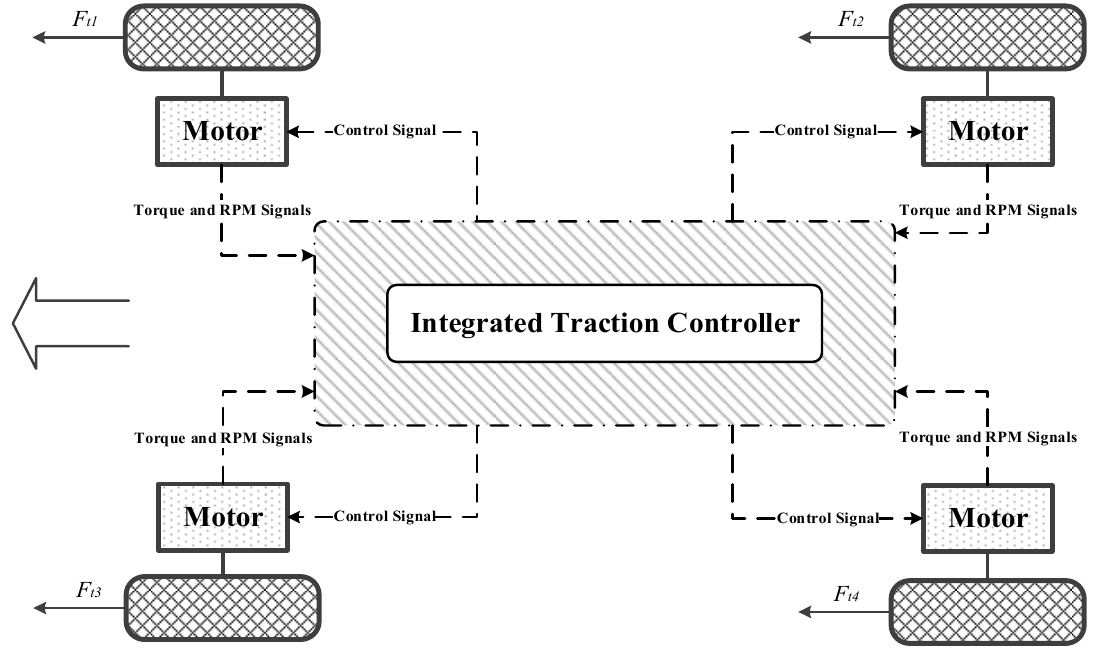
Figure 1. Chassis and traction control system layout. RPM: revolutions per minute.